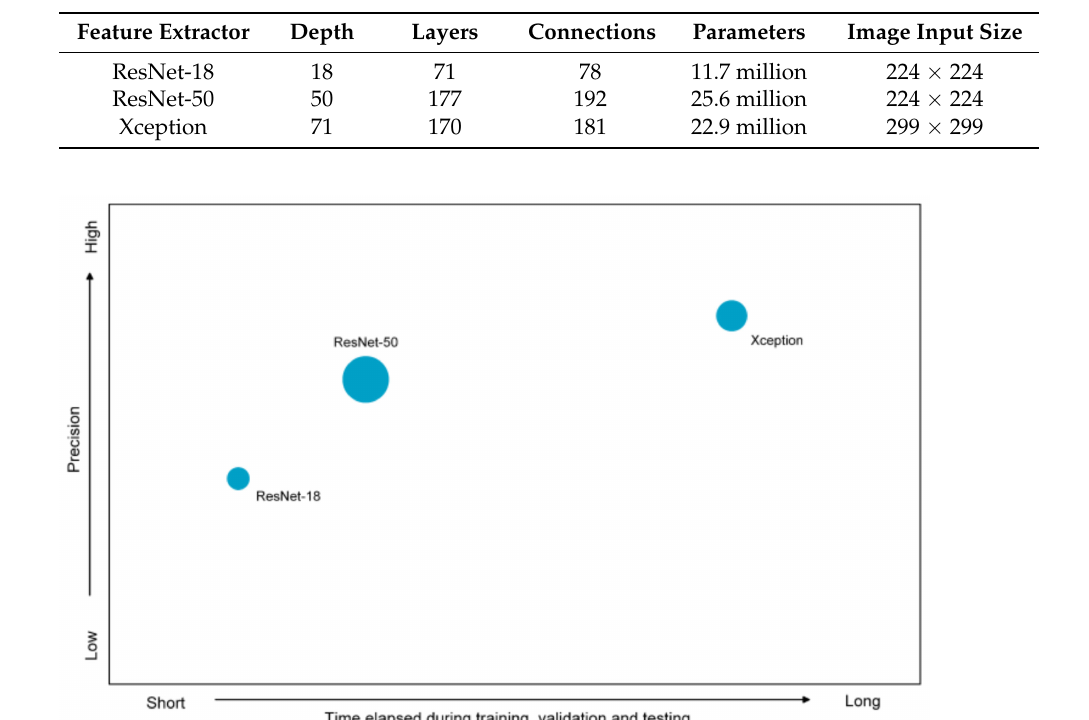
Figure 6. Schematic of relative scale, duration time of training, validation and testing, and precision of three feature